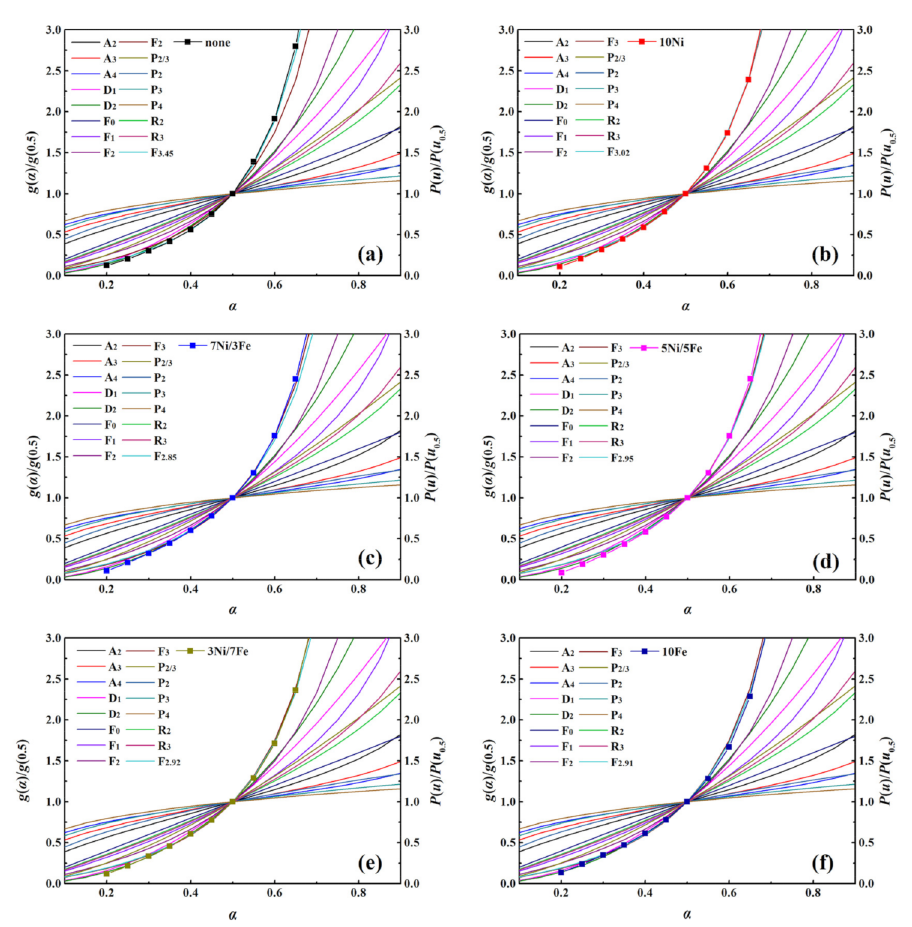
Figure 4. g ( α )/ g (0.5) versus α for WT pyrolysis with no catalyst and five synthesized catalysts at the heating rate of 20 ◦ C/min ( a ) No catalyst; ( b ) 10Ni; ( c ) 7Ni/3Fe; ( d ) 5Ni/5Fe; ( e ) 3Ni/7Fe; ( f )